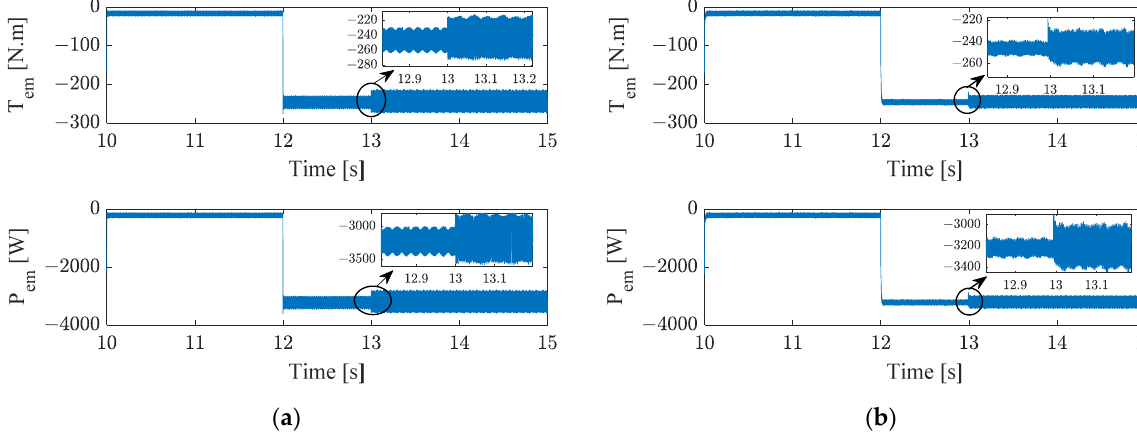
Figure 10. Faulty mode results of electromagnetic torque and power: ( a ) with PI controller; ( b ) with FLC.